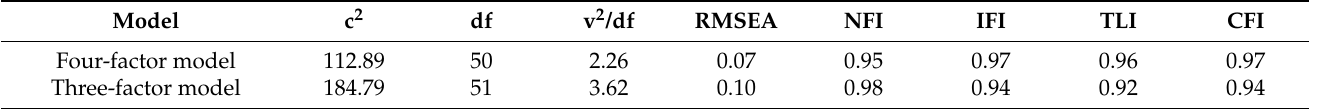
Table 1. Measurement model and results of confirmatory factor analysis.